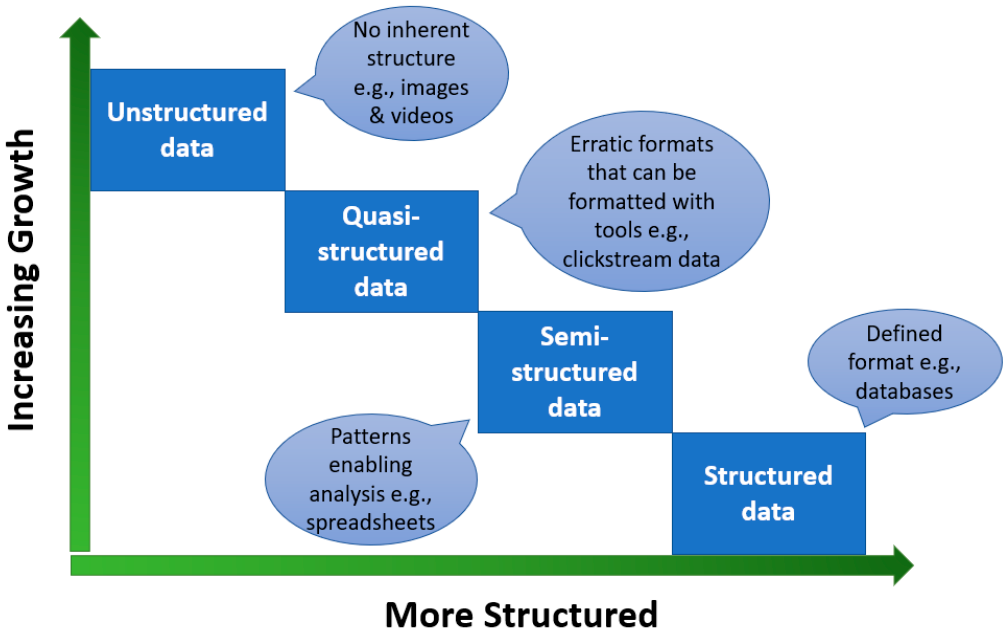
Figure 3. Di ff erent types of big Figure 3. Different types of big data.